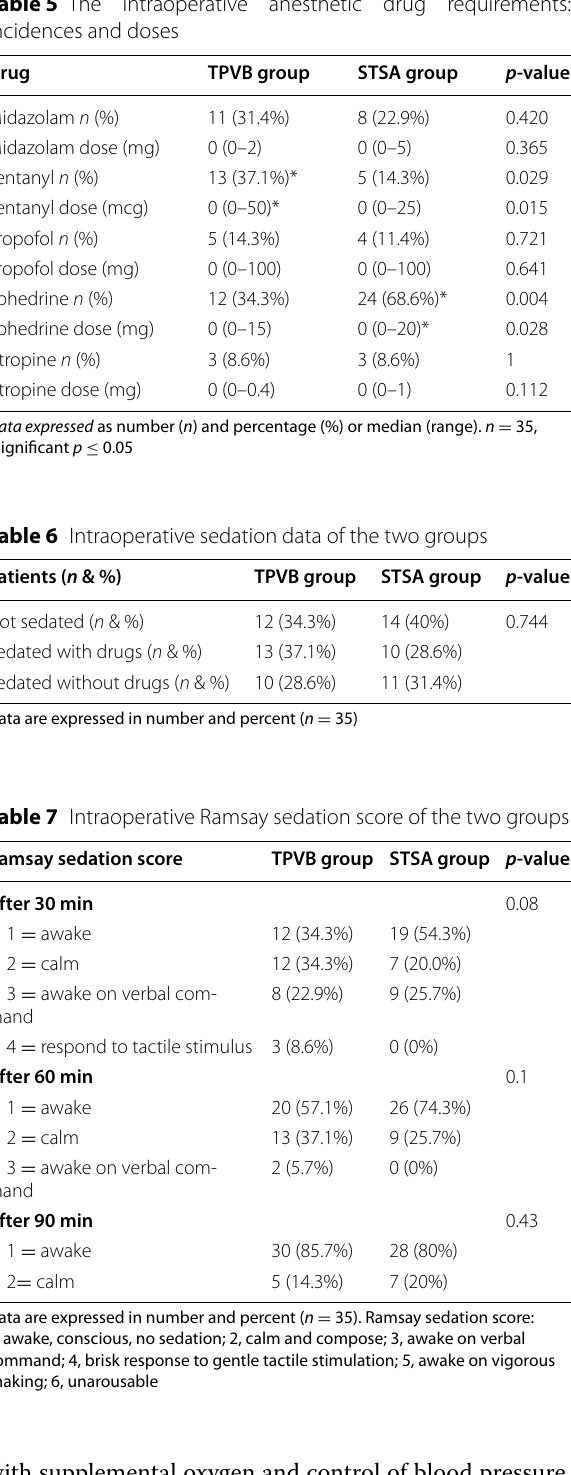
35). Ramsay sedation score: =